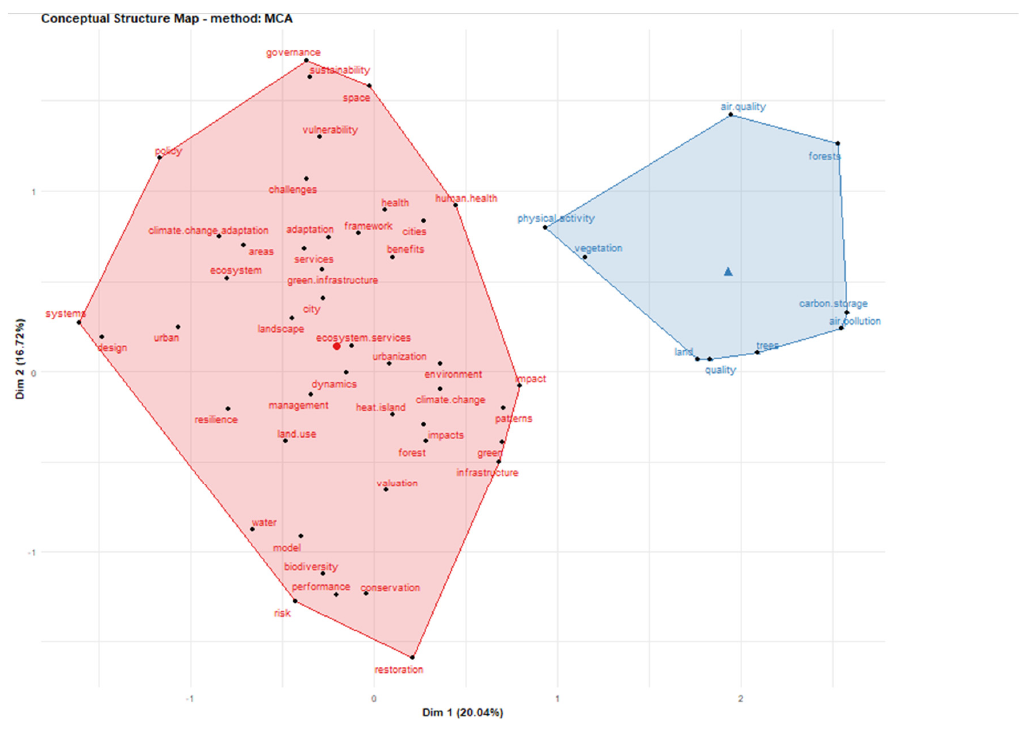
Figure 13. Conceptual Structure Map by Keywords Plus. Source: Biblioshiny. Own compilation.